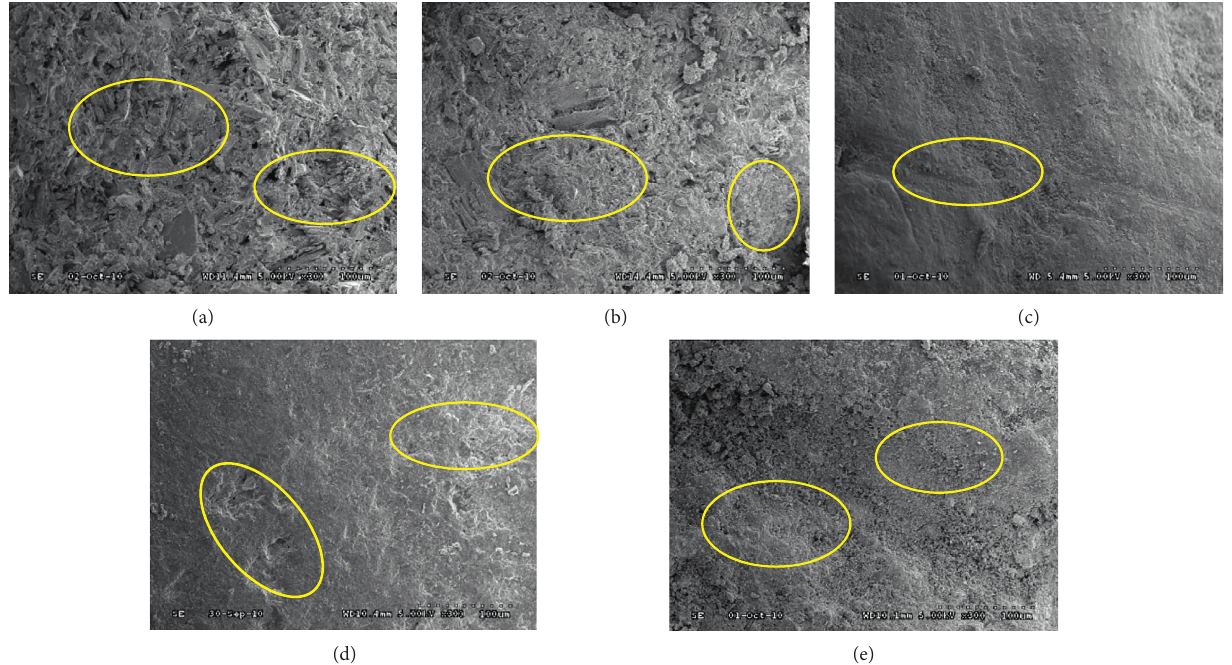
Figure 10: SEM photos of similar material samples with different NBe contents: (a) the structure is loose and contains many holes; (b) the structure gradually compacted and a large number of holes became smaller; (c) the surface is denser and the structure contains more pores; (d) the interface of the structure is smooth and dense with only a few holes; (e) the structure interface is agglomerated and there are many holes ( × 300 times).